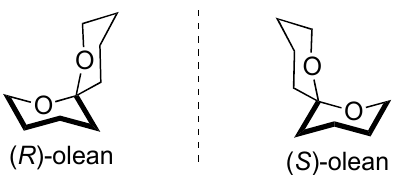
Figure 1. Structures of ( R )- and ( S )-1,7-dioxaspiro[5.5]undecane (olean).